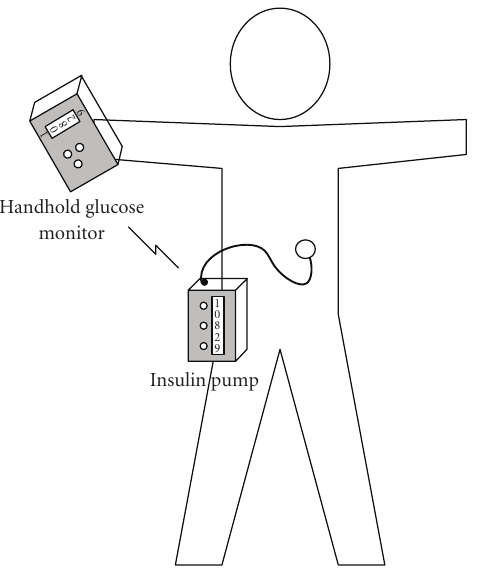
Figure 2: An image of an insulin pump. This image also includes a blood glucose sensor. In the general use, an insulin pump continu- ously infuses a little amount of the short-acting exogenous insulin via an attached needle as a basal dosage. It is also able to add extra exogenous insulin for intensive care, for example, meal time. Insulin pumps have a lot of advantages compared with the insulin shots.